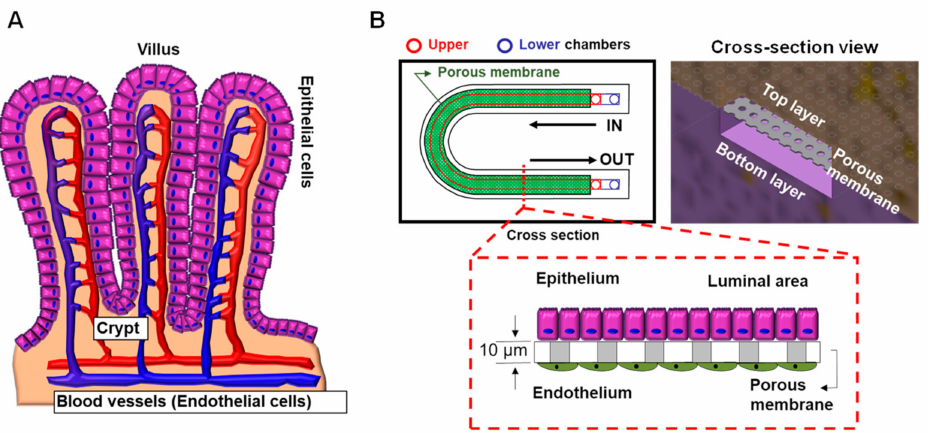
Figure 6. In vitro co-culturing model, gut-on-a-chip. ( A ) A schematic representation of human intestinal mucosa with associated vasculature. ( B ) A novel gut-on-a-chip model was designed to mimic the in vivo structure of the human intestinal mucosa. This system allows researchers to co-culture intestinal epithelial cells and endothelial cells in the same